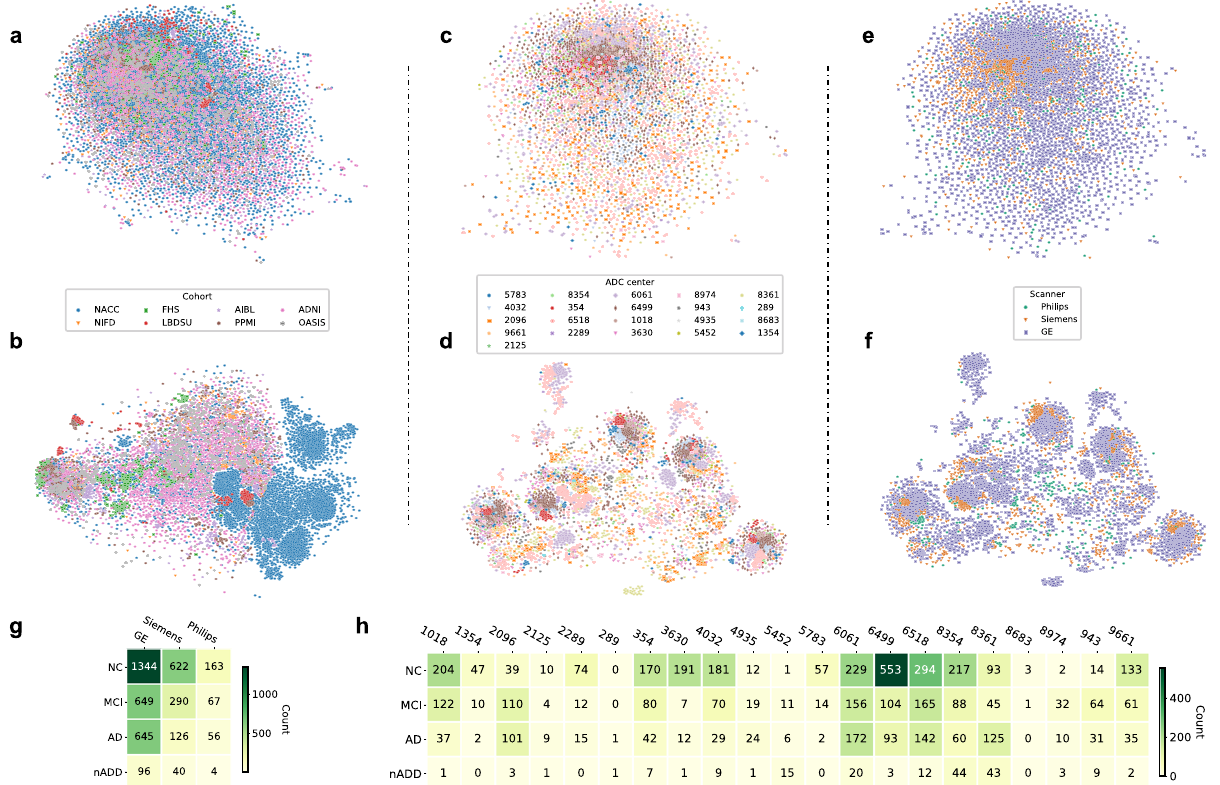
Fig. 2 Site- and scanner-speci fi c observations. Unsupervised clustering of post-processed MRIs and hidden layer activations assessed for systematic biases in input data and model predictions, respectively. a Two-dimensional (2D) t-distributed stochastic neighbor embedding (tSNE) embeddings of downsampled MRI scans are shown. The downsampling was performed on the post-processed MRI scans using spline interpolation with a downsampling factor of 8 on each axis. Individual points represent MRIs from a single subject and are colored according to their original cohort (either NACC, ADNI, AIBL, FHS, LBDSU, NIFD, OASIS, or PPMI). b We demonstrate 2D tSNEs of hidden-layer activations from the penultimate CNN hidden layer. Individual points correspond to internal representations of MRI scans during testing and are colored by cohort label. c Plot of 2D tSNE embeddings of downsampled MRI scans from the NACC dataset is shown. Individual points representing MRI scans are colored by the unique identi fi er of one of twenty-one Alzheimer Disease Research Centers (ADRCs) that participate in the NACC collaboration. d tSNE embeddings for penultimate layer activations colored by ADRC ID are shown. e Plot of 2D tSNE embeddings of downsampled MRI scans from the NACC dataset is shown. Embeddings in this plot are the same as those in c but colored according to the manufacturer of the scanner used to acquire each MRI, either General Electric (GE), Siemens, or Philips. f Plot of 2D tSNE of penultimate layer activations is shown for cases in the NACC dataset. Embeddings are equivalent to those visualized in d but are now colored by the manufacturer of the scanner used for image acquisition. g A tabular representation of disease category counts by manufacturer is presented. Only cases from the NACC dataset are included. We provide the Mutual Information Score (MIS) to quantify the correlation between disease type and scanner manufacturer. h We also provided a tabular representation of disease category counts strati fi ed by ADRC ID in the NACC dataset. MIS is once again shown to quantify the degree of correlation between diagnostic labels and individual centers participating in the NACC study. Source data are provided as a Source Data fi